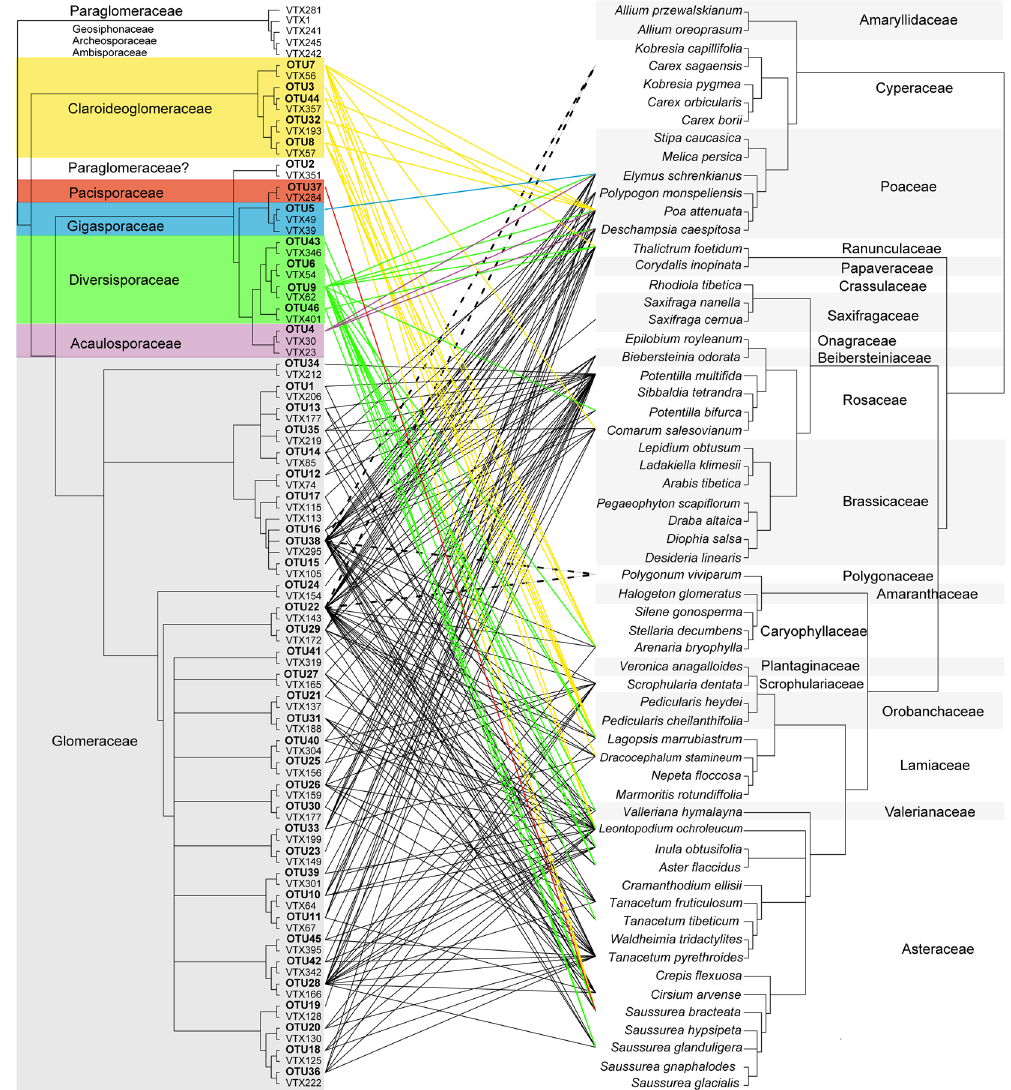
Figure 2. Two cladograms of Bayesian majority-rule consensus tree showing the position and relationship between recorded AMF (cladogram on left site, based on partial sequence of SSU r RNA) and host plants (cladogram on right site, based on ITS, trnT-trnL, matK + trnK, and rbcL). Connections between them are colored by fungal family: Claroideoglomeraceae (yellow), Paraglomeraceae (white), Pacisporaceae (red), Gigasporaceae (blue), Diversisporaceae (green), Acaulosporaceae (violet) and Glomeraceae (gray with black lines). Interrupted lines indicate connection between fungi and putative non-mycorrhizal plants. The AMF tree includes the detected OTUs together with the most closely related virtual taxa (VTX) from MaarjAM database. The full version of the AMF cladogram with Bayesian posterior probabilities is in Fig. S1. Potentilla pamirica (associated with 6 OTUs) and Tanacetum stolickae (associated with 2 OTUs) is omitted in the plant cladogram due to the lack of their sequences in